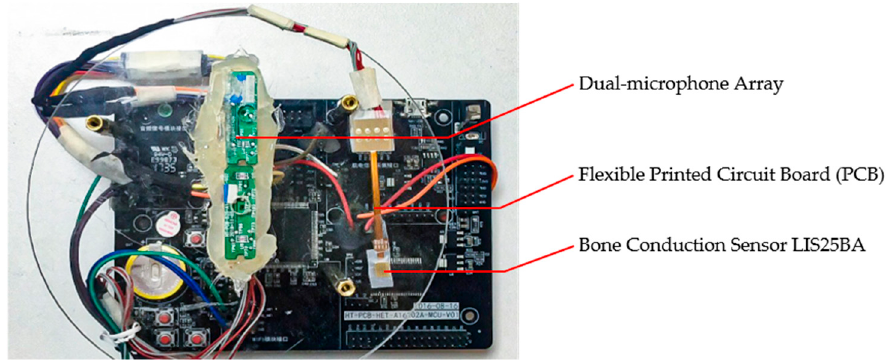
Figure 8. The STM32 development board with the dual-microphone array and the bone conduction sensor LIS25BA. Table 1. The postfilter (single-channel) speech enhancement results obtained with optimally modified log-spectral amplitude (OMLSA), Recurrent neural network (RNN) noise and the proposed method, where noisy means the unprocessed original signal.